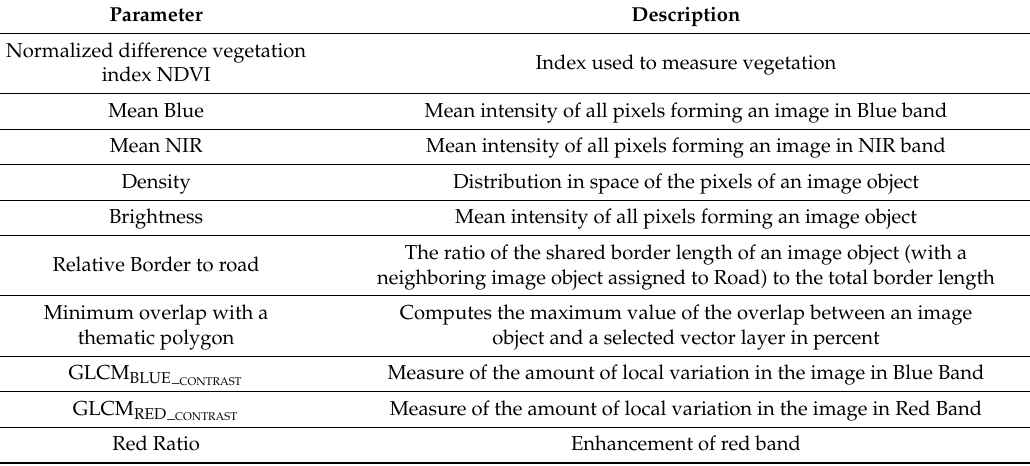
Table 3. Description of parameters used in the classification of the study